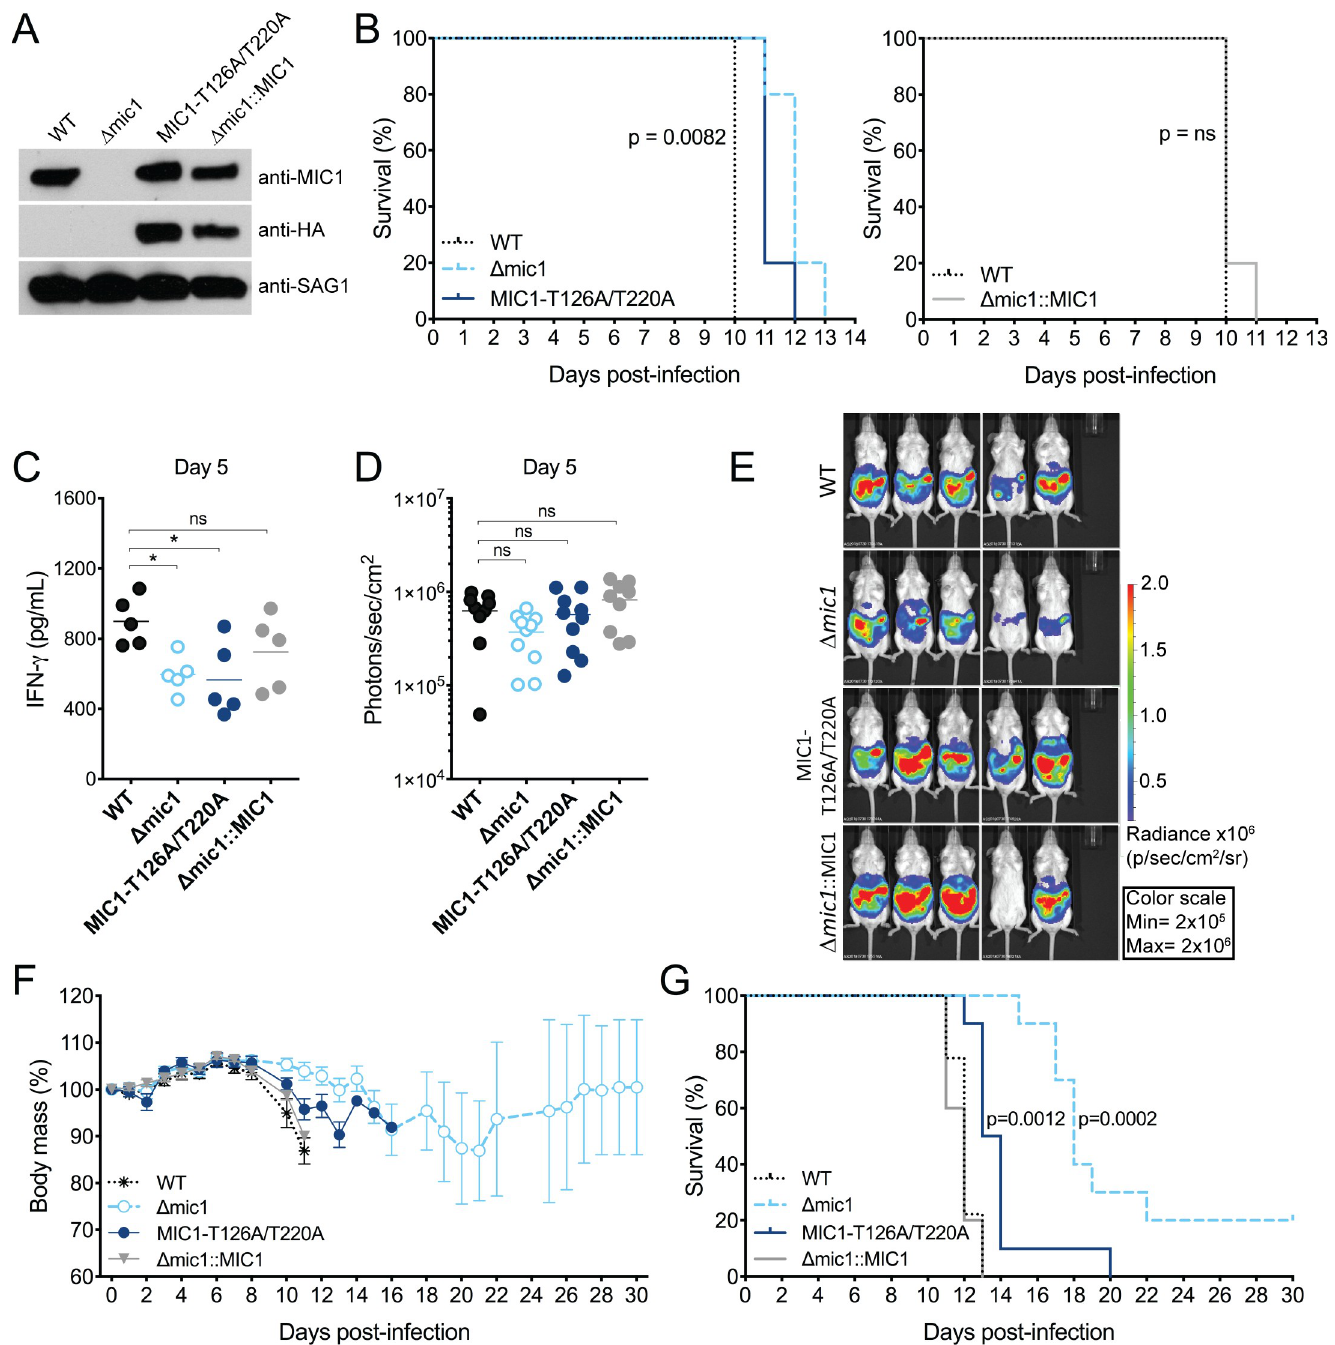
Fig 7. MIC1 wild type complemented strain restores virulence in mice during in vivo infection with T . gondii . (A) Western blot analysis of an equal loading of whole cell lysates corresponding to 3 × 10 6 tachyzoites (1 x 10 8 /mL) from WT, Δ mic1 , Δ mic1 ::MIC1-T126A/T220A and Δ mic1 ::MIC1 parasites. The membrane was probed with anti-MIC1 (IgY, 1:20,000), anti-HA (rabbit, 1:5,000) and anti-SAG1 (rabbit, 1:10,000). (B) Mortality kinetics of CD-1 mice infected intraperitoneally with WT, Δ mic1 , Δ mic1 ::MIC1-T126A/T220A and Δ mic1 ::MIC1 at an infectious dose of 50 tachyzoites/mouse (n = 5). (C) At day 5 post-infection the sera were collected for measuring systemic IFN- γ . (D and E) Bioluminescent detection in photons/sec/cm 2 shows parasite burden 5 days post-infection. (F and G) Body mass and mortality kinetics of CD-1 mice infected subcutaneously with WT, Δ mic1 , Δ mic1 ::MIC1-T126A/T220A and Δ mic1 ::MIC1 using an infectious dose of 10 4 tachyzoites/ mouse. Data are expressed as mean ± S.D. and significance were calculated with ANOVA followed by Bonferroni’s multiple comparisons test. � p < 0.05. Data are representative of two independent experiments, total n = 10.